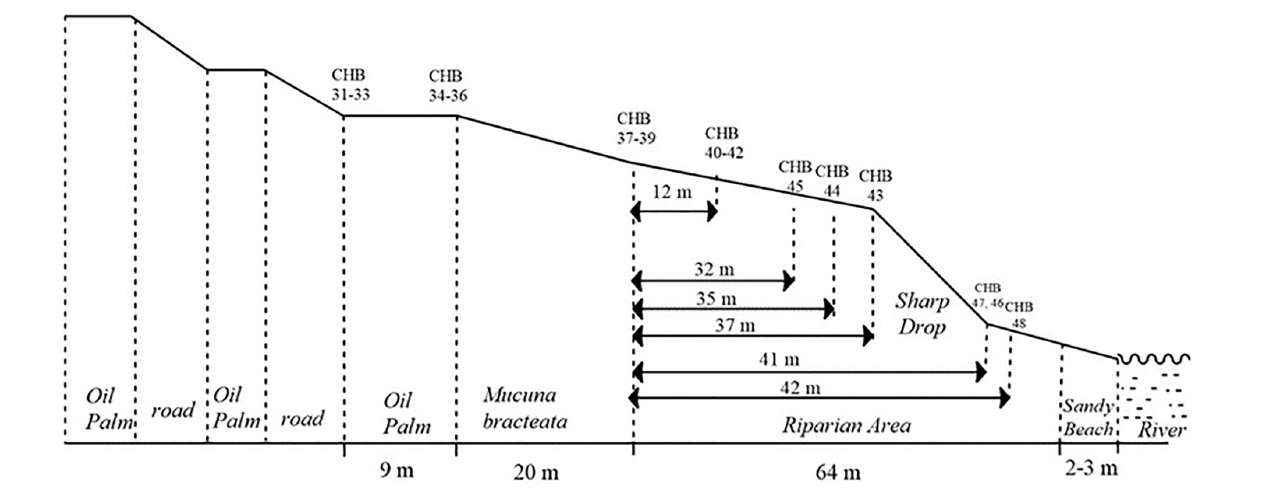
FIGURE 1 | Layout of the transects from oil palm plantation via riparian forest to the river, using transect 3 as an example. Chambers (CHB) 31–36 are in the oil palm plantation. Chambers 37–48 are in the riparian forest. There are six rows of three chambers each across the